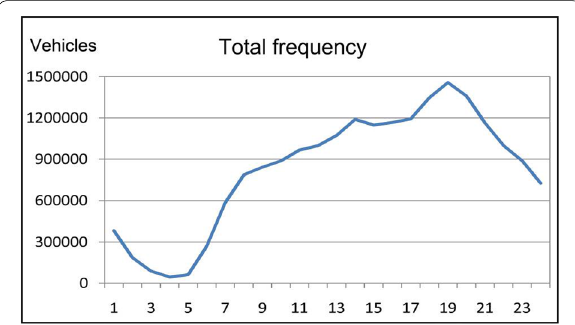
Fig. 3 Distribution of detecting vehicles in each hour based on the total frequency of vehicles in